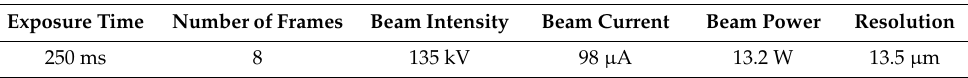
Table 2. Parameters and settings of computed tomography (CT) examinations for measurements in the gage length area of tensile and fatigue specimens.